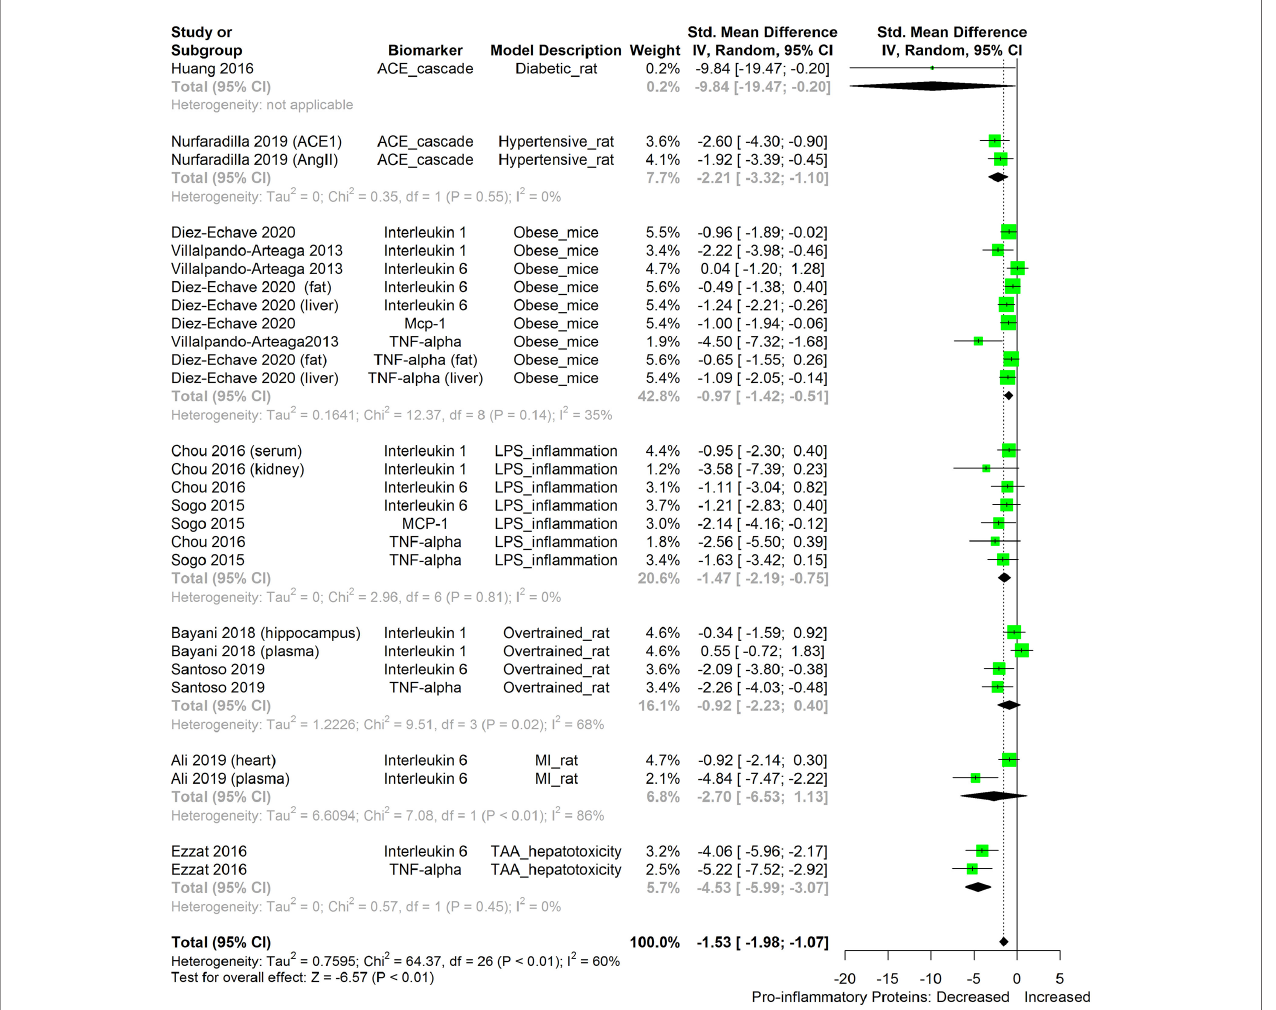
FIGURE 13 | Meta-analysis and forest plot of the effect of HS administration on selected pro-in fl ammatory biomarkers (ACE, TNF- a , IL-6, IL-1 b , MCP-1) across different diseased-rodent models. The meta-analysis was sub-grouped by rodent ’ s disease models (i.e diabetic rats, hypertensive rats, LPS-in fl ammation model, over-trained rats, MI-rats, TAA-hepatotoxicity models). The standardized mean difference (SMD), which is an estimate of the effect size, is presented as a square on the forest plot, for each study and as a diamond for the pooled estimate of each subgroup or overall studies. The overall pooled SMD for all included studies is shown in the bottom section of the forest plot. SMD data points that are lower than zero signify that treatments with HS lowered the level of the biomarker while those greater than zero signify that HS treatment causes an increase in the levels of the biomarker. The statistical signi fi cance of the pooled estimate is indicated by the Z test of signi fi cance. MI, Myocardiac infarction; LPS, Lipopolysaccharide; TAA, Thioacetamide; TNF-alpha, Tumor necrosis factor-alpha; MCP-1, Monocyte chemoattractant protein-1; ACE, Angiotensin-converting